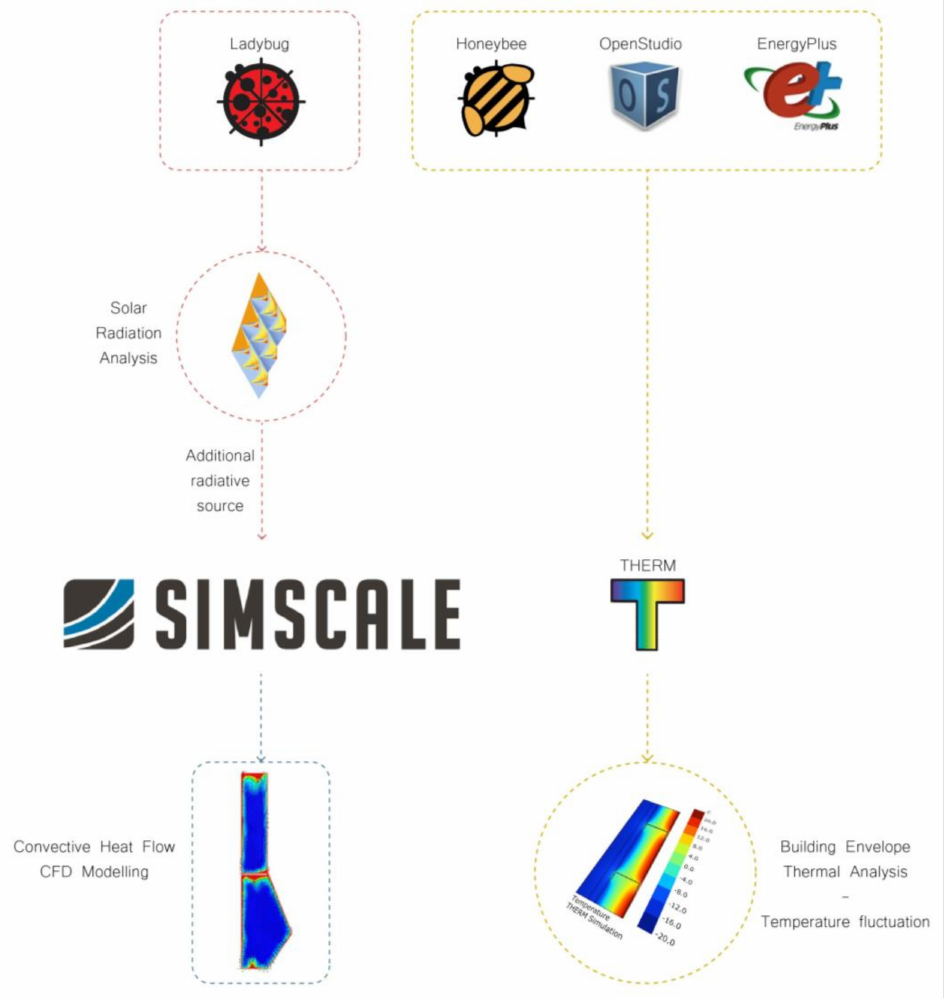
Figure 10. Overview of the toolchain and the data interchange between the different design tools used for the thermal simulation